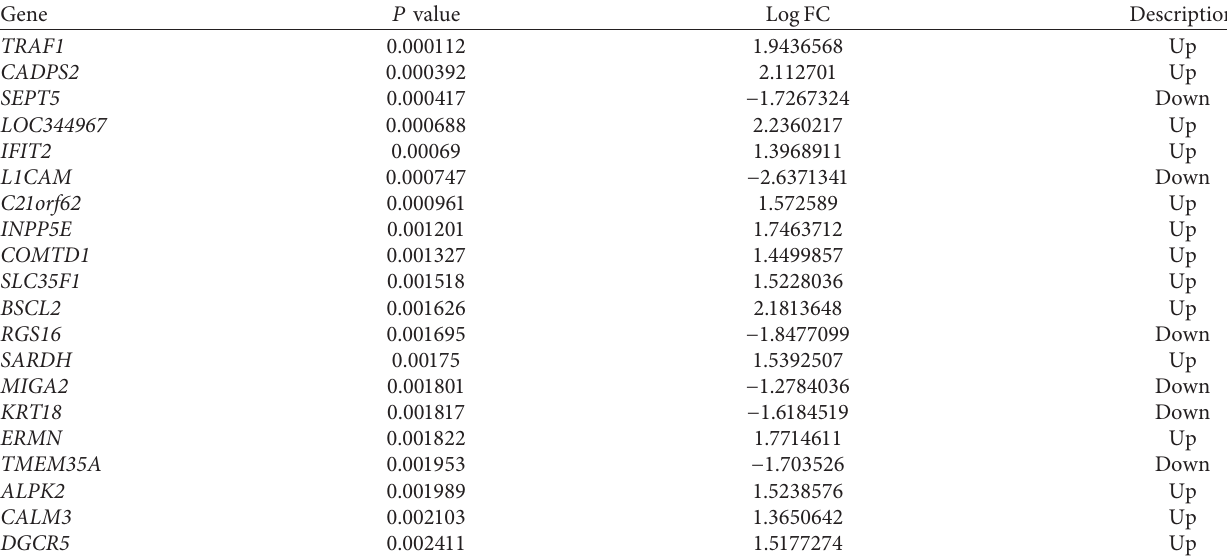
Table 1: The top 20 of DEGs.